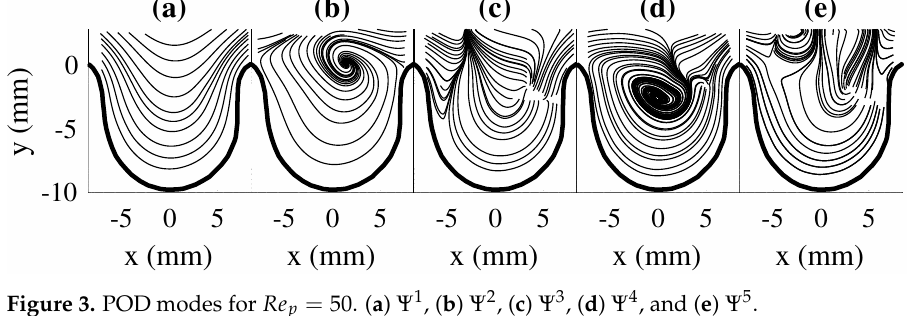
Figure 3. POD modes for Re p = 50. ( a ) Ψ 1 , ( b ) Ψ 2 , ( c ) Ψ 3 , ( d ) Ψ 4 , and ( e ) Ψ 5 .